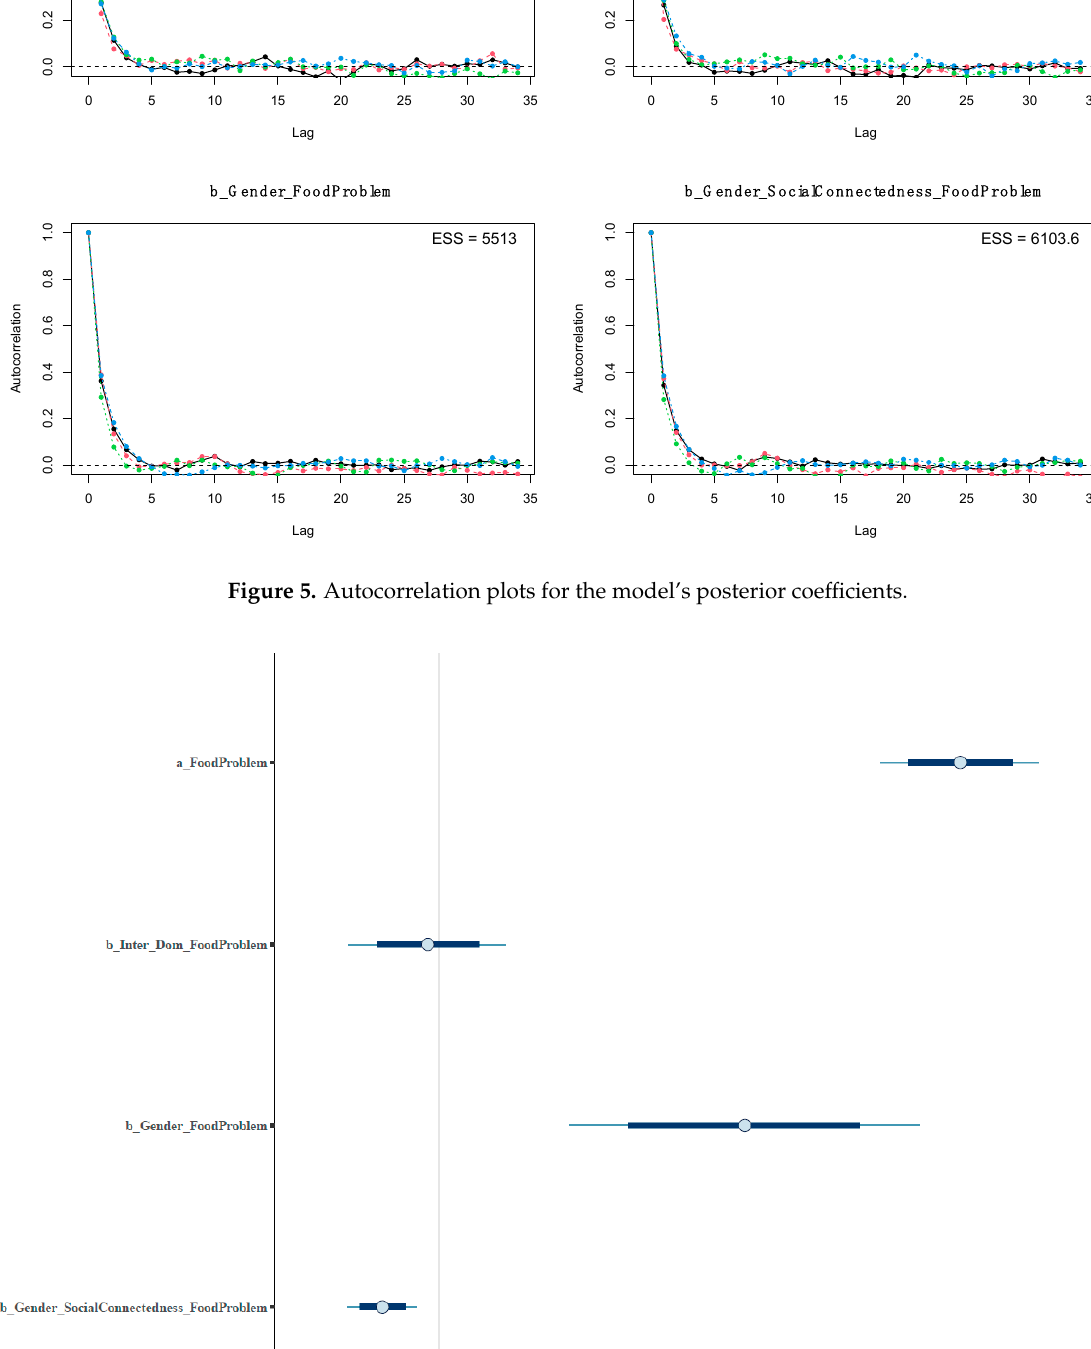
Figure 6. Interval distributions of the model’s posterior coefficients.